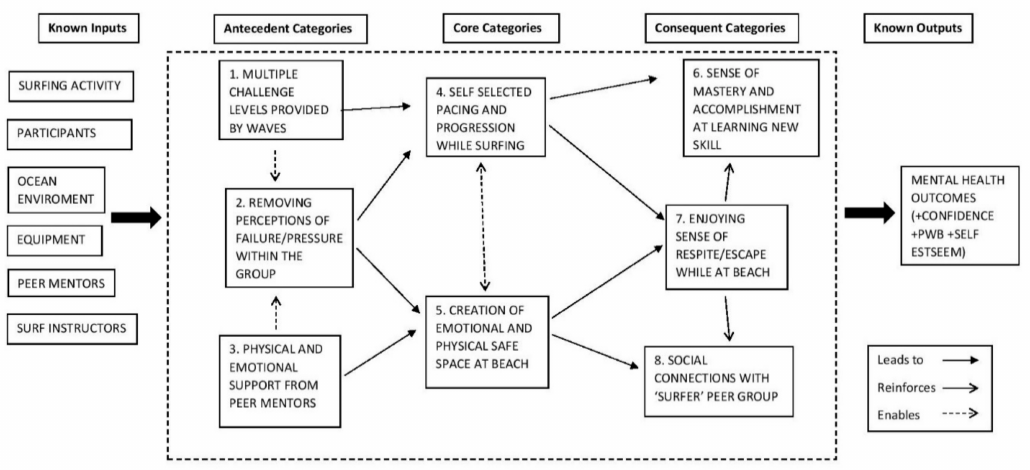
Figure 3. Logic model s howing mechanisms of